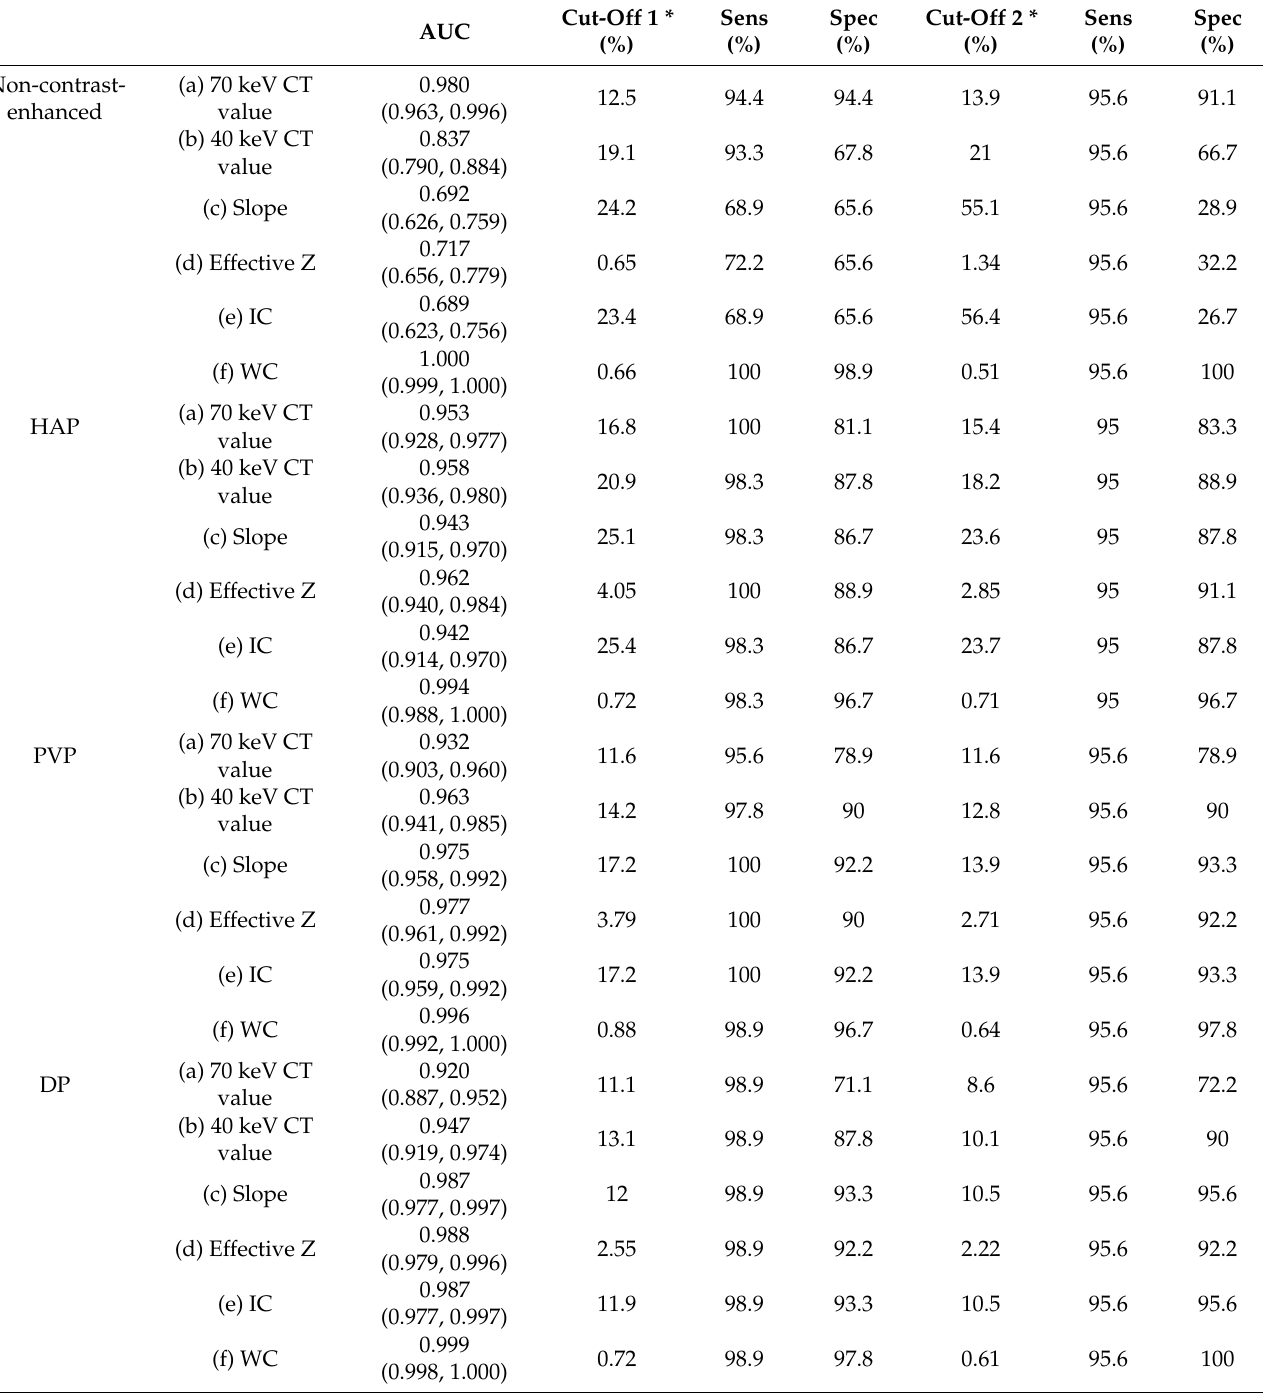
Table 2. ROC analyses between the difference in DECT numbers obtained from two ROIs placed on the same organs and the difference in DECT numbers obtained from two ROIs placed on different organs.